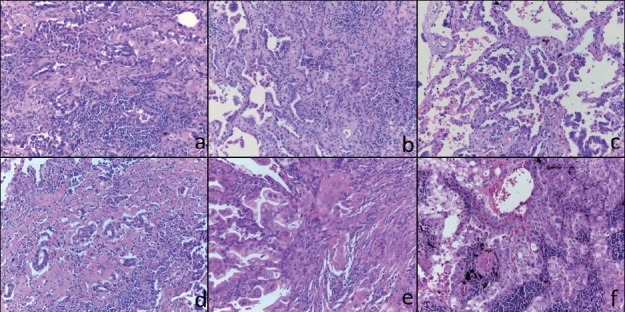
Histological features of the six tumours included in this study. Representative micrographs of the six tumours showing adenocarcinoma with a prevalent lepidic and/or acinar growth pattern (a-f) with focal formation of micropapillae in case 3 (c) and solid nests in case 6 (f). Haematoxylin and eosin-stained slides; original magnification 200x.